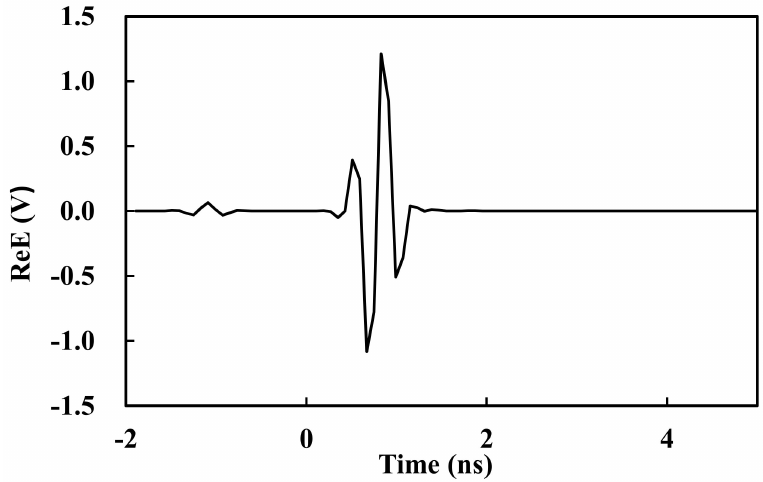
Figure 13. Time − domain response of dihedral angle based on